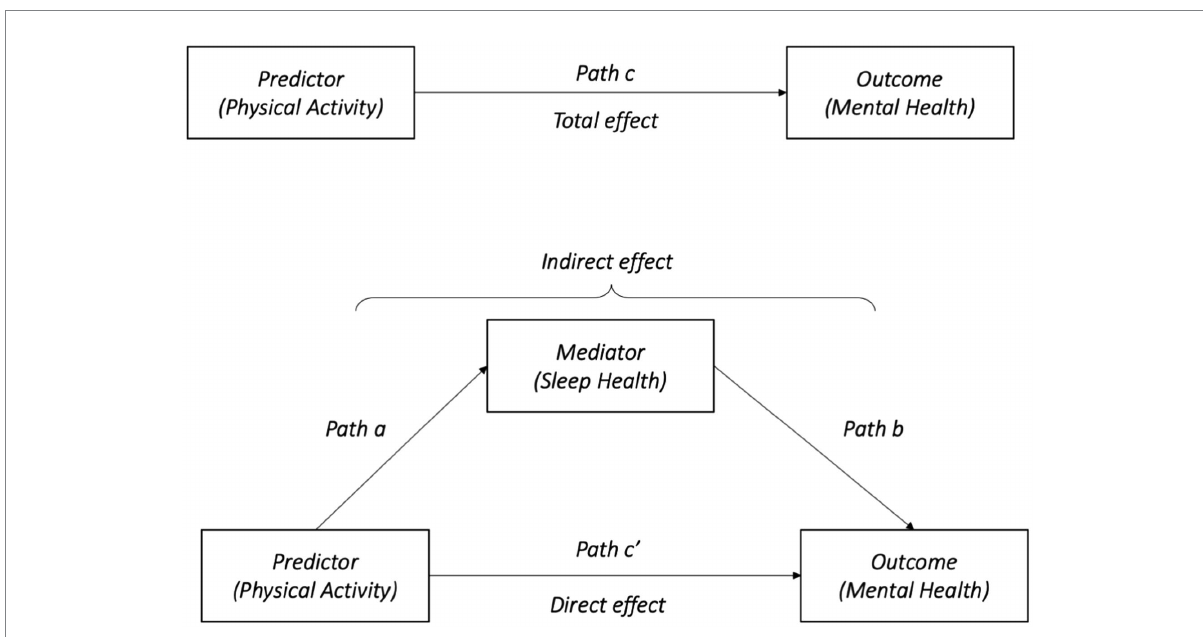
FIGURE 1 Conceptual model: how sleep disorder mediates the association between physical activity and mental health. a, b, c, and c’ refer to the path of models.